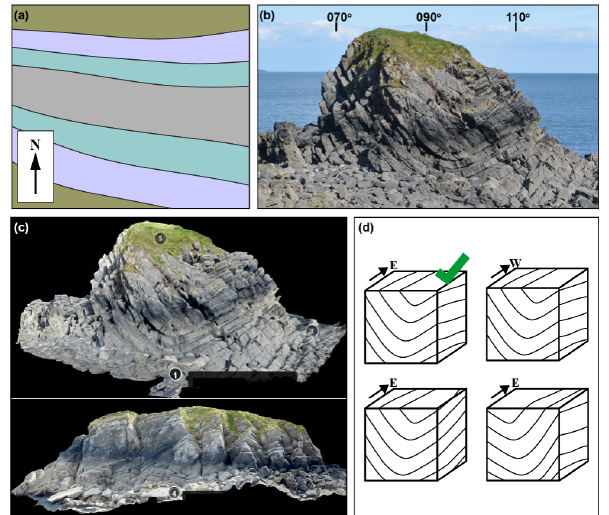
Figure 1. Representations of the Stackpole syncline, Pem- brokeshire. (a) Map view. (b) Field photograph with marked ori- entation directions. (c) Views of the virtual outcrop, with the top view pointed east and the bottom view pointed south. The num- bered annotations seen on the virtual outcrop give the participants the directional information and are embedded into the viewer. (d) The four block diagrams from which participants had to choose the most accurate representation. The most accurate representation is the top left block diagram indicated with a green